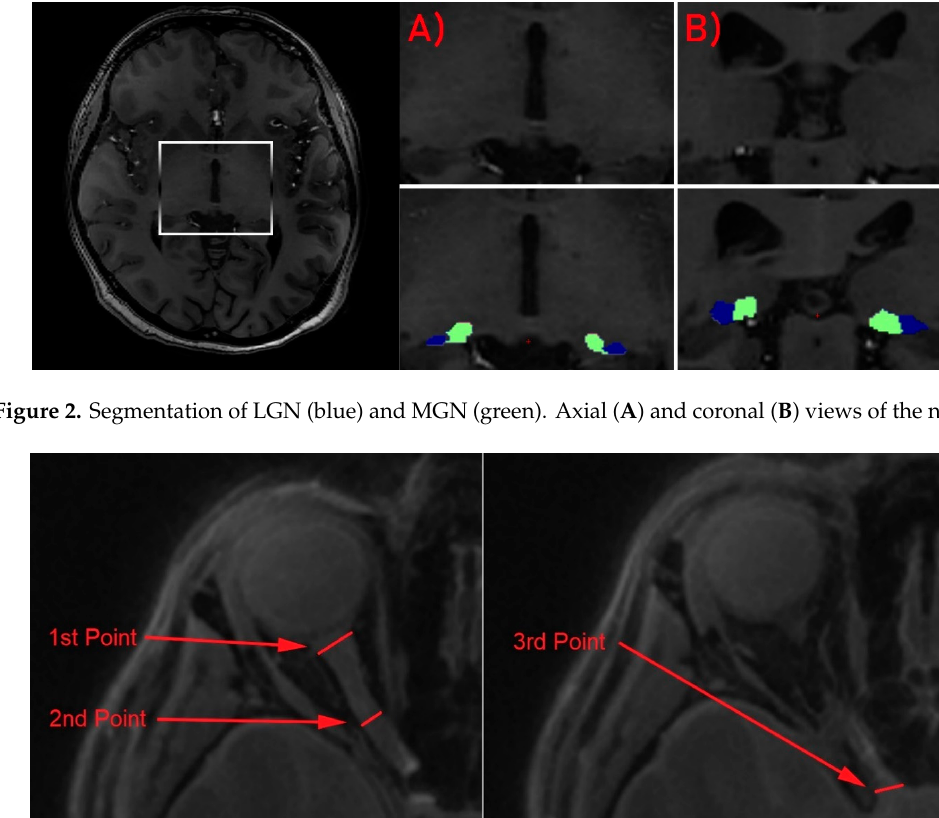
Figure 2. Segmentation of LGN (blue) and MGN (green). Axial ( A ) and coronal ( B ) views of the nuclei.